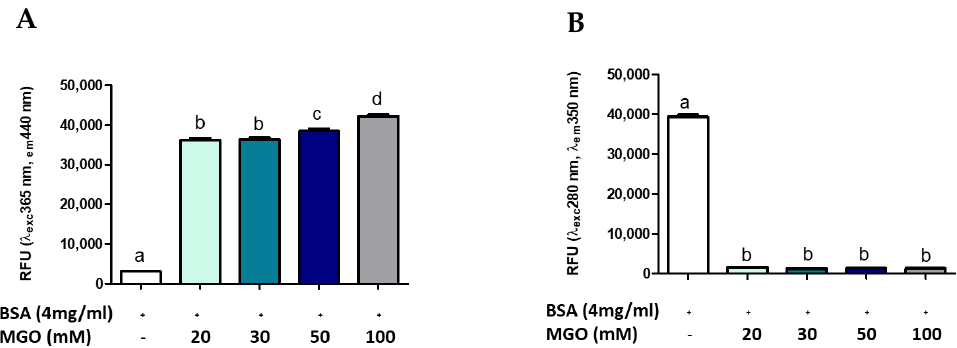
Figure 3. Fluorescence measurement of AGE after 168 h of incubation. All values are expressed as M ± SD ( n = 3). Data represent relative fluorescence units ( A ) RFU λ exc 365 nm/ λ em 440 nm and ( B ) RFU λ exc 280 nm/ λ em 350 nm of BSA non-glycated (BSA) and BSA glycated (BSA+MGO). Different letters represent significant differences among sample (ANOVA one-way and Tukey post-test).